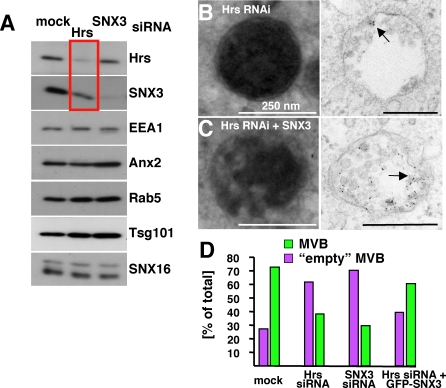
SNX3 Rescues the Formation of Internal Vesicles in Hrs siRNA-Treated Cells(A) HeLa cells treated with siRNAs against Hrs or SNX3 or mock-treated were lysed. Lysates were analyzed by SDS gel electrophoresis and western blotting using indicated antibodies. The red box highlights the reduction in SNX3 levels observed after Hrs knockdown.(B) HeLa cells were treated with Hrs siRNAs. Then, the endosomal content was labeled with HRP (left panel) or 5-nm proteinA-gold (right panel) and analyzed by electron microscopy as in Figure 4A.(C) As (B), except that GFP-SNX3 was overexpressed during the last 24 h.(D) The number of MVBs and “empty” MVBs were counted in the experiments shown in Figure 4A (mock-treated cells), Figure 4B (SNX3 siRNAs), Figure 5B (Hrs siRNAs), and Figure 5C (Hrs siRNAs followed by SNX3 overexpression), and are expressed as a percentage of the total number of HRP-labeled endosomes (≈50 individual endosomes counted for each condition). All structures containing one or more intralumenal vesicles were counted as MVBs). To ensure unbiased analysis and quantification, micrographs were taken in Brisbane, and each condition was number coded. Analysis and quantification were then performed blind in Geneva.